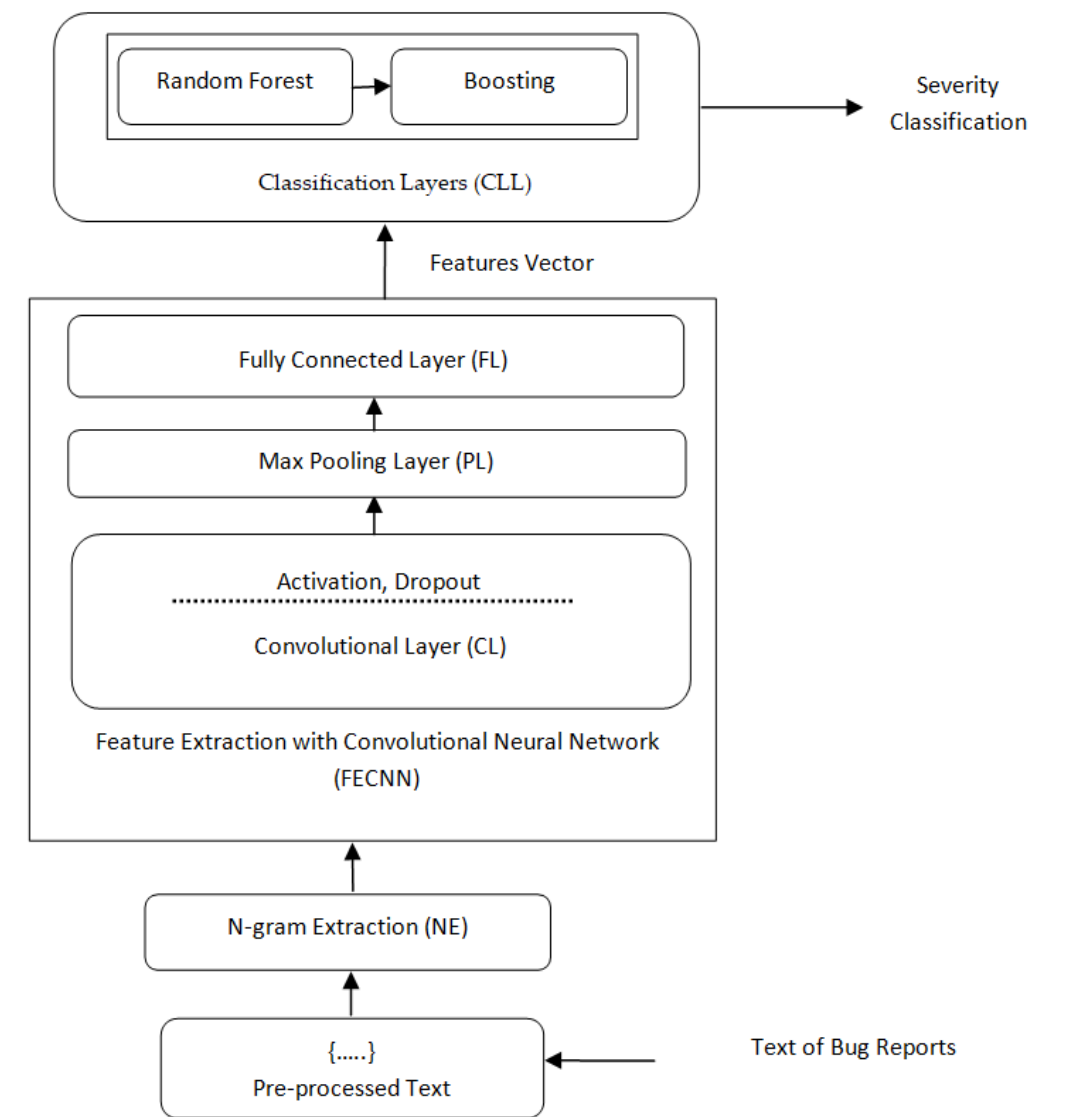
Figure 4. The steps of the BCR model for bug severity classification .